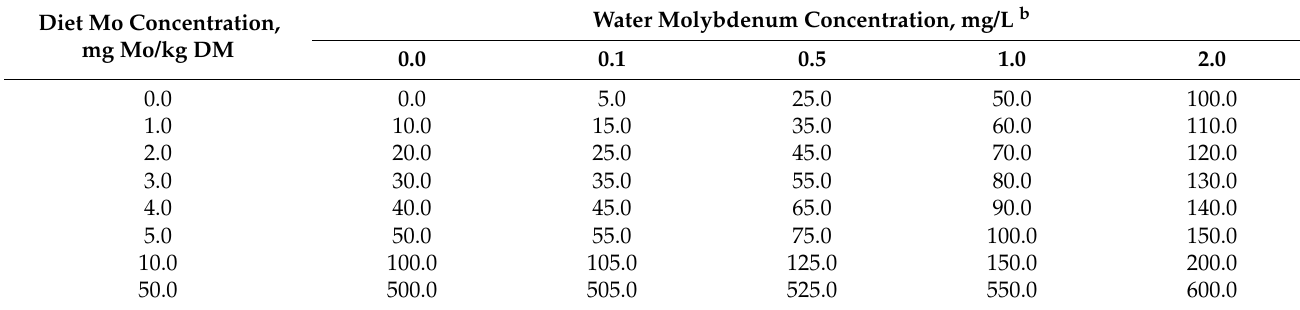
Table 2. Calculated influence of water molybdenum (Mo) concentrations and dietary molybdenum concentrations on total Mo intake, total mg of Mo consumed per day for beef cattle a